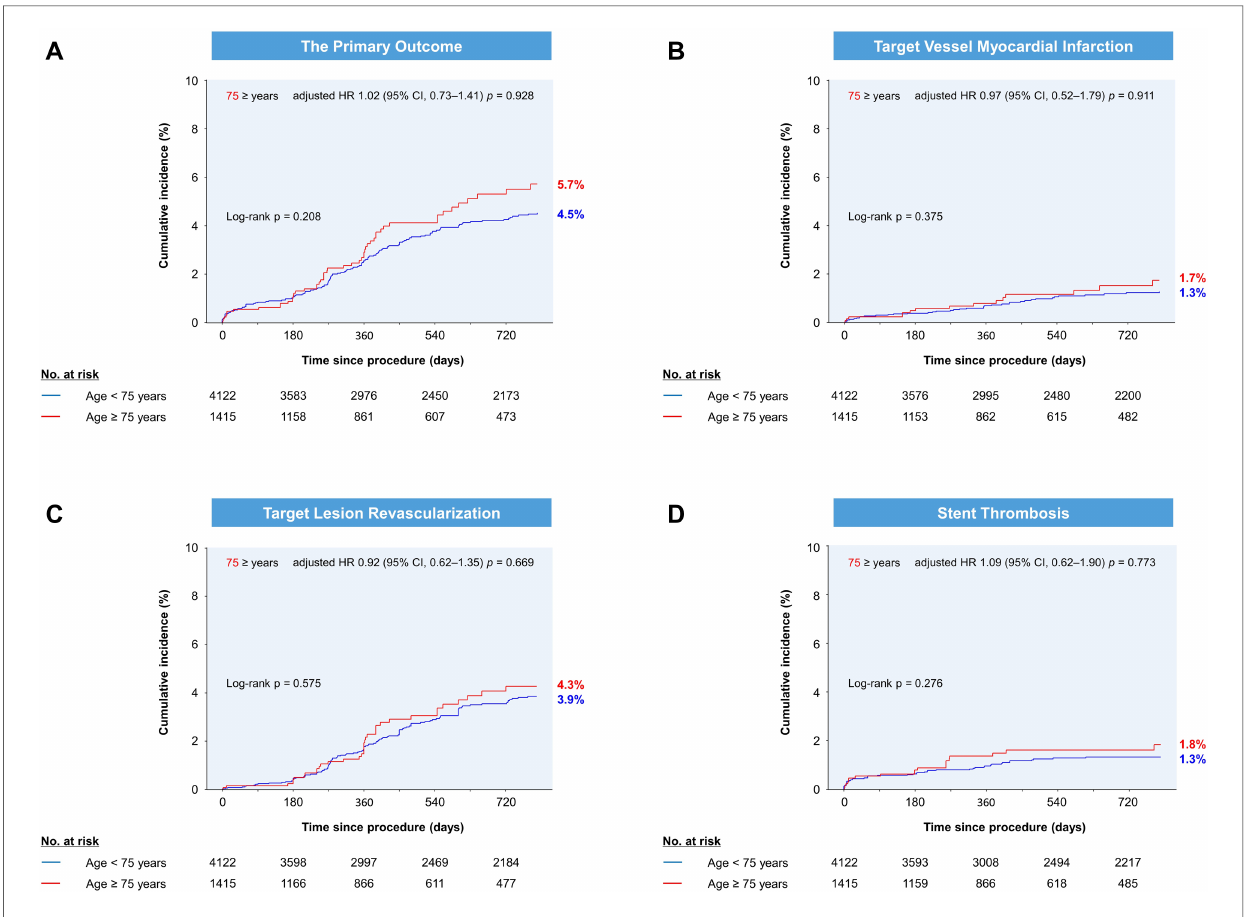
FIGURE 1 Cumulative incidence of ( A ) the primary outcome, ( B ) target vessel myocardial infarction, ( C ) target lesion revascularization, and ( D ) stent thrombosis by age group. The Kaplan-Meier estimates at 720 days are shown. HR, hazard ratio; CI, con fi dence